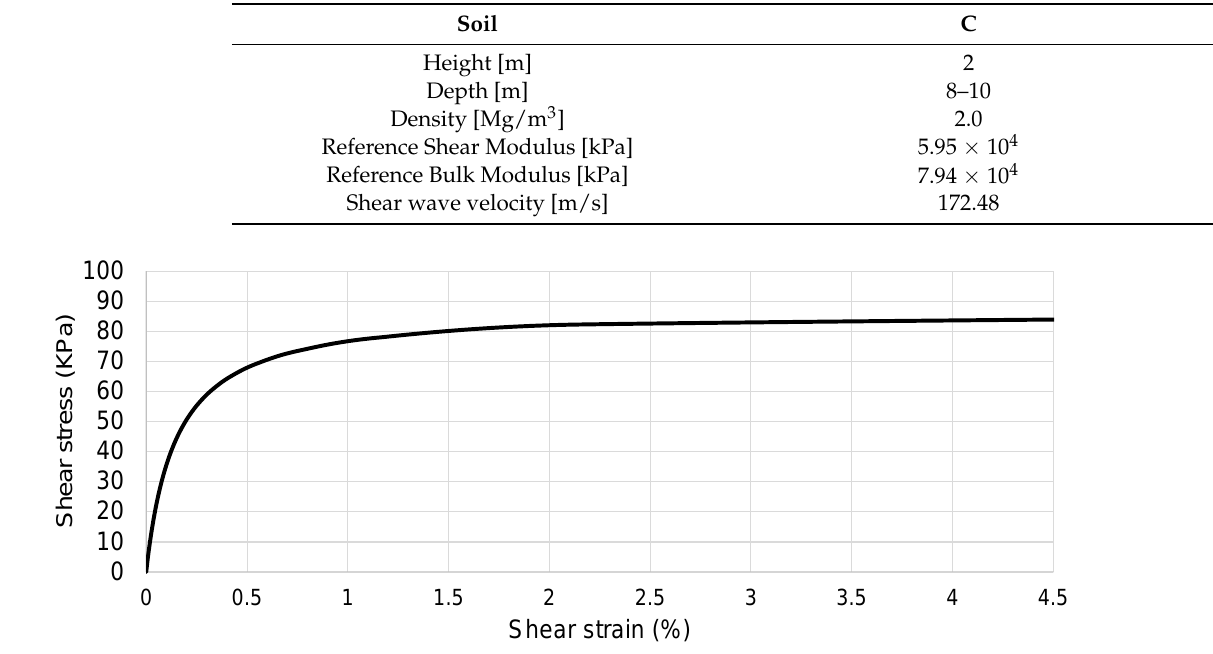
Table 3. Soils C characteristics.